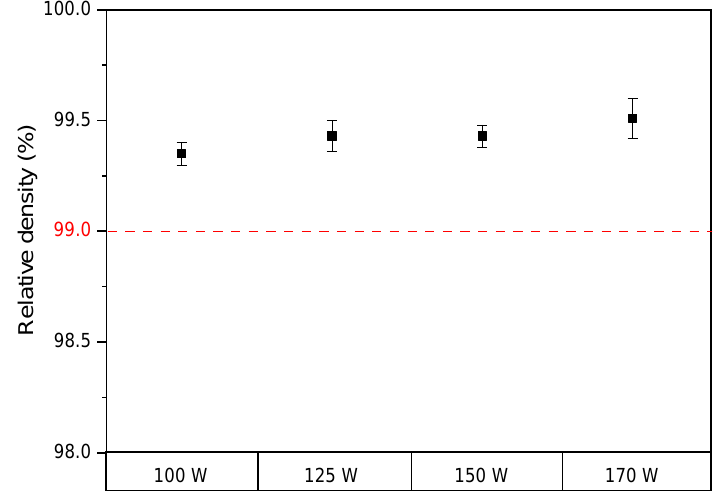
Figure 3. Relative density of the Al-Mn-Cr-Zr samples at various power values.